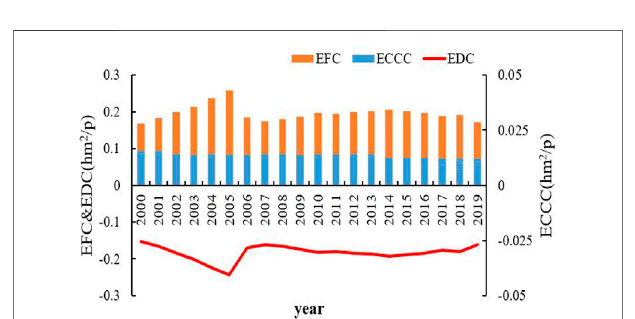
FIGURE 6 | 2000 – 2019 ECCC, EFC, and EDC of grassland in Sichuan Province.